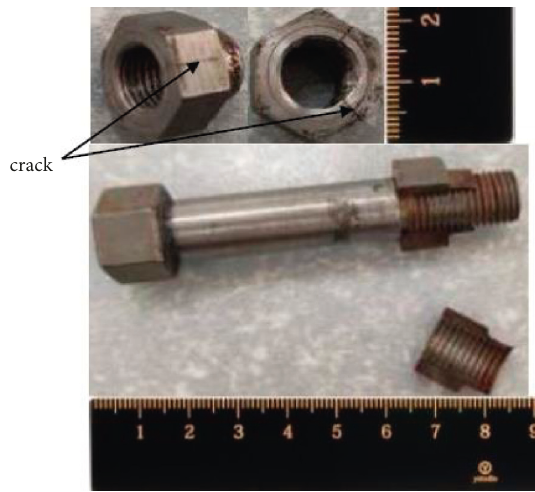
Figure 1: The phenomenon of nut damage.